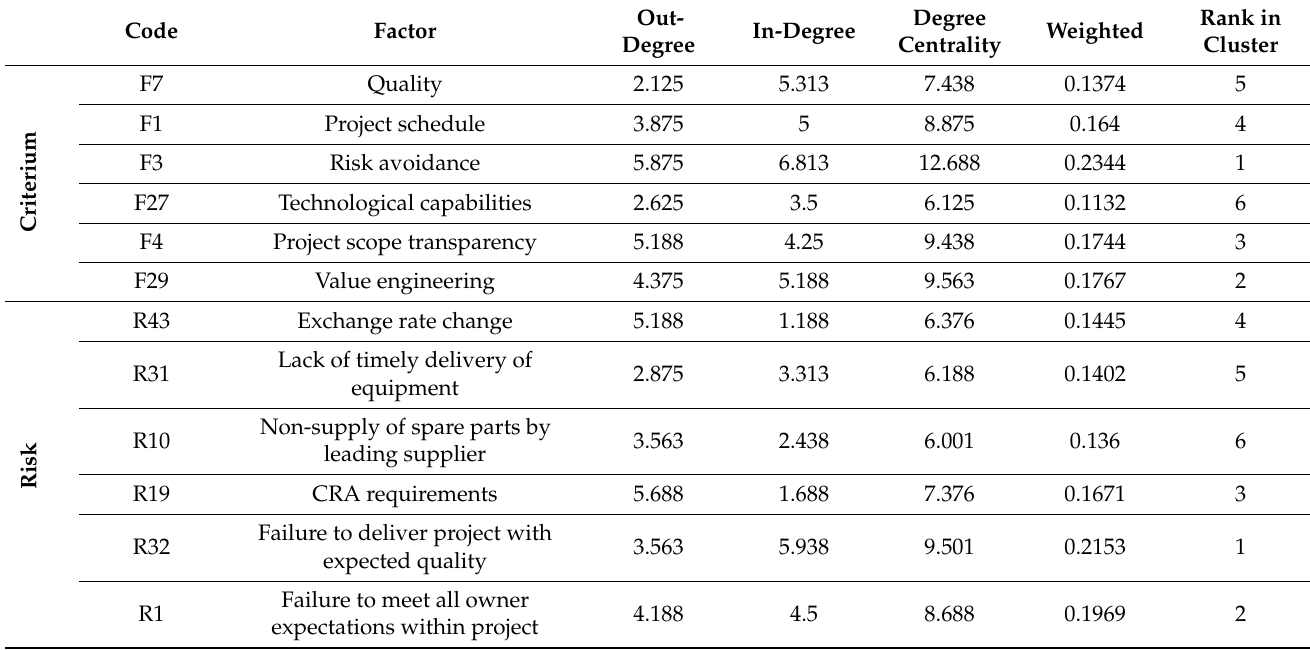
Table 6. Centrality measures of the